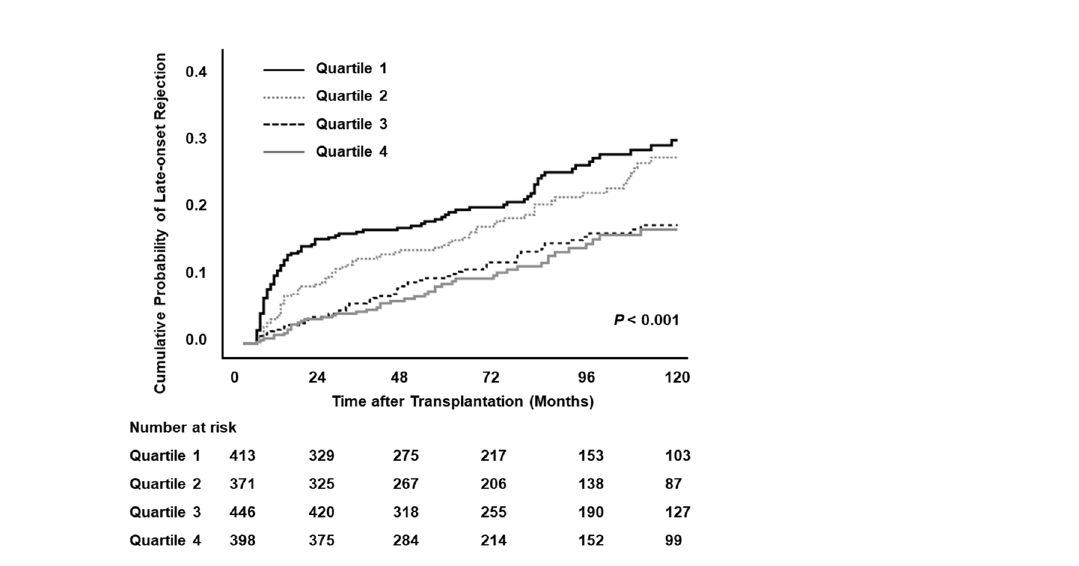
Figure 4. Late-onset rejection according to serum bilirubin level.